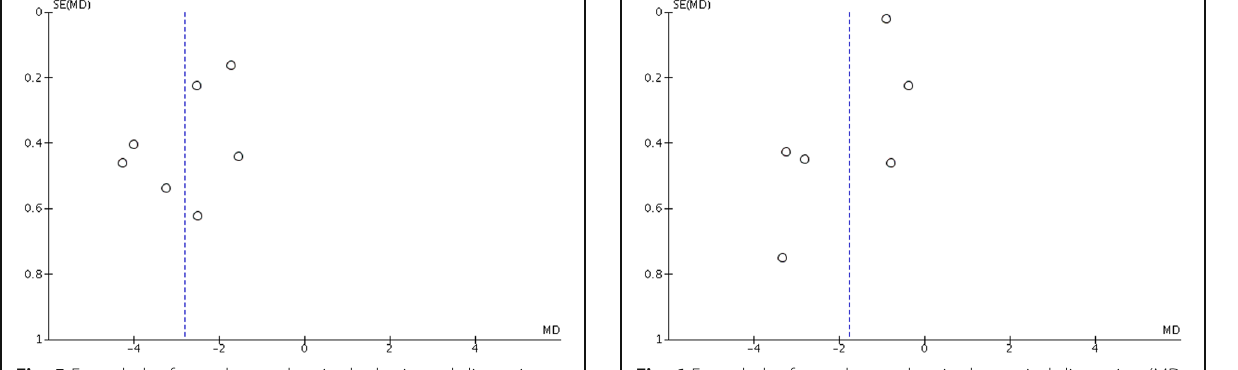
Fig. 5 Funnel plot for anchorage loss in the horizontal dimension (MD mean difference, SE standard error)